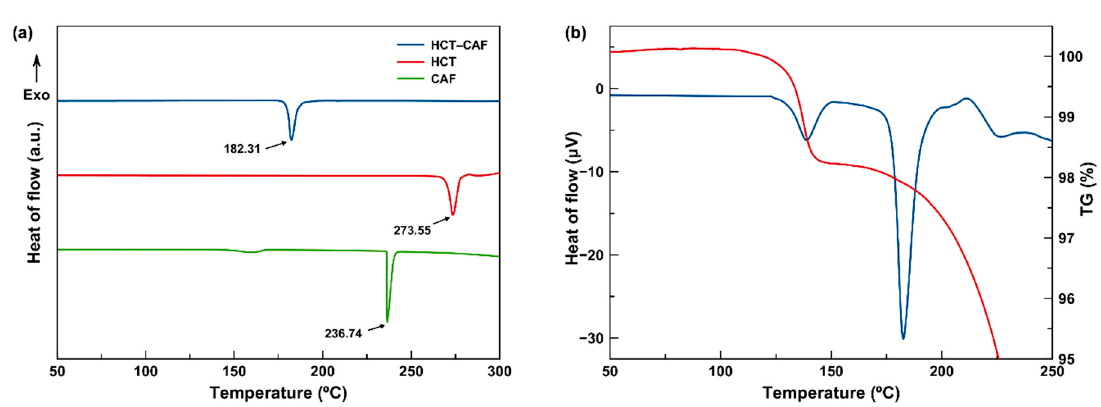
Figure 7. ( a ) Differential scanning calorimetry (DSC) plots of HCT–CAF cocrystal and its components. ( b ) Thermogravimetric-differential scanning calorimetry (TG-DSC) plots of HCT–CAF·MET. Blue line denotes DSC plot and red line denotes TG plot.